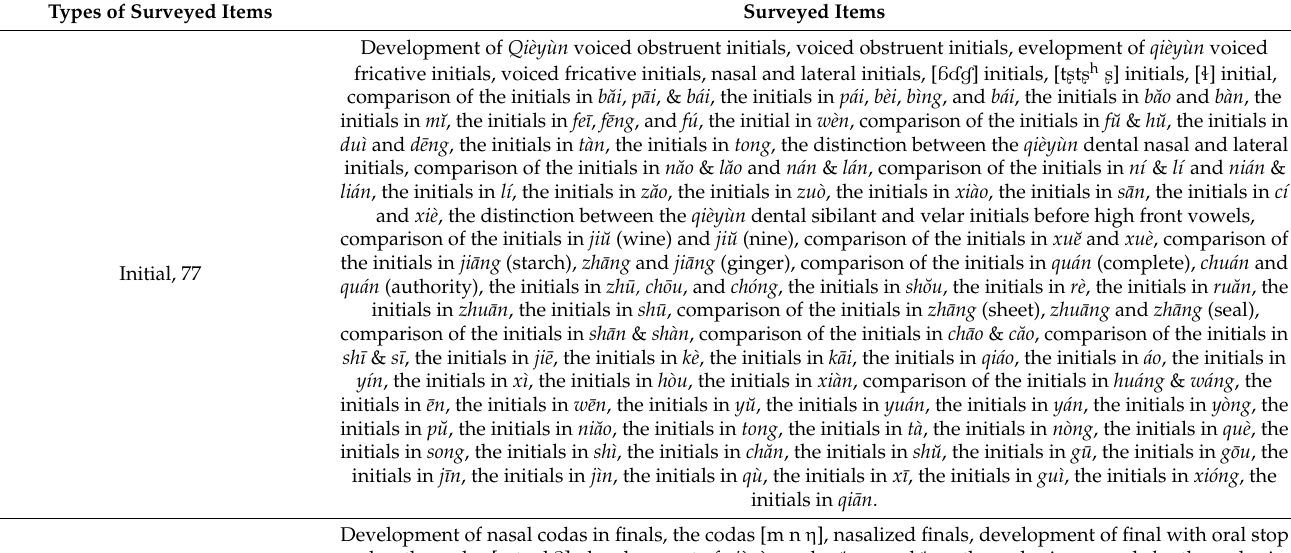
Table A1. Phonologies, pronunciations of special characters, and phonetic values of Chinese dialects surveyed by the Linguistic Atlas of Chinese Dialects · Phonetics